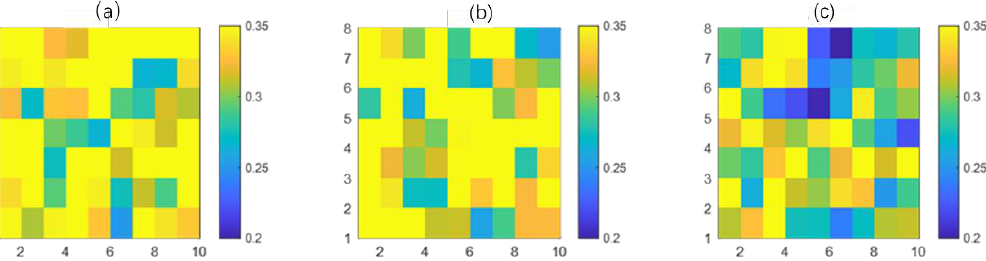
Figure 8. OP_IBS values for three recordings from ( a ) the normal group, ( b ) the mild–moderate OSA group and ( c ) the severe group.